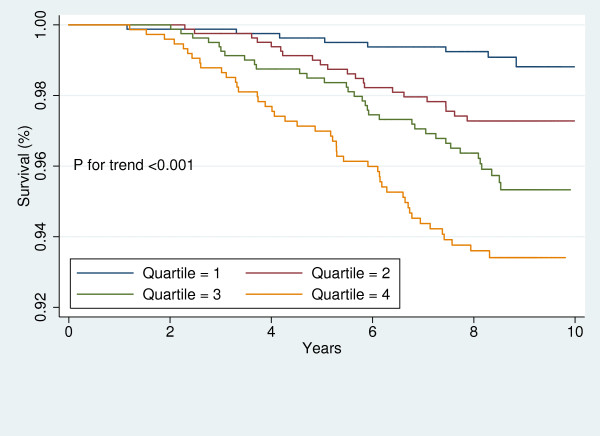
Kaplan-Meier curves for incident CVD across LAP quartiles in women with global CVD risk less than 20%.